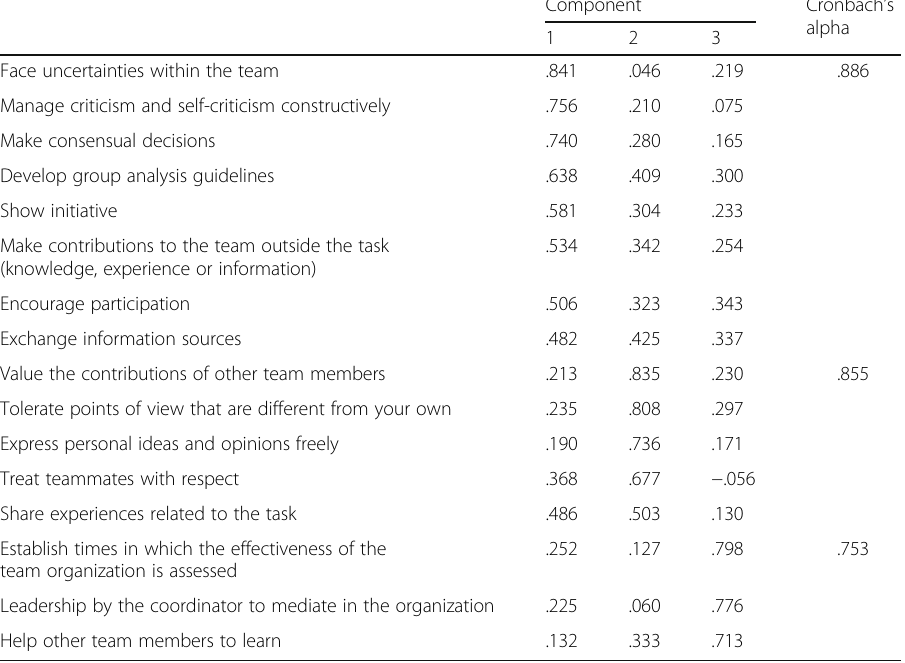
Table 4 Rotated component matrix and